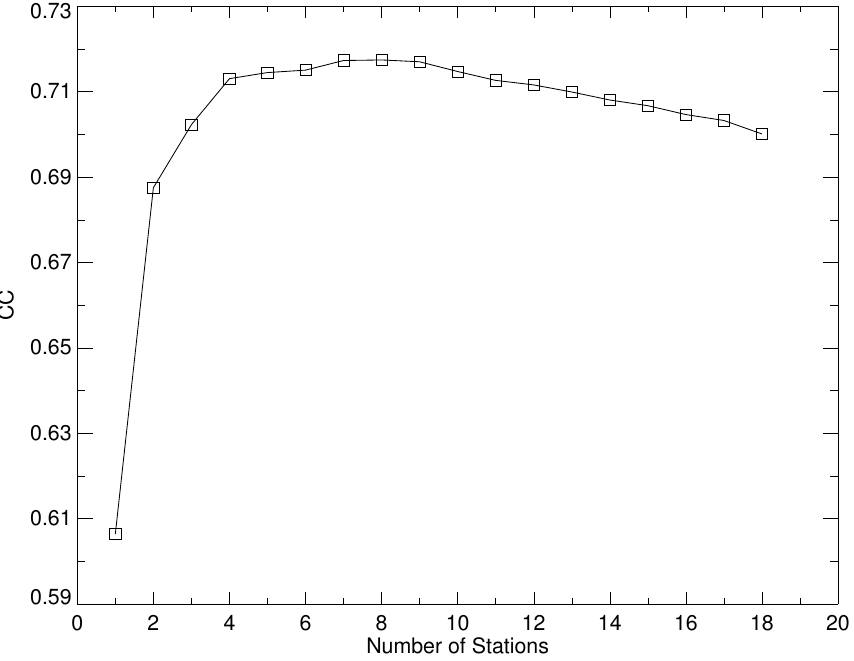
Figure 2. The variation of the CC between the Dst index and the J G p index when the number of stations used in the construction of J G p varies from 1 to 18.